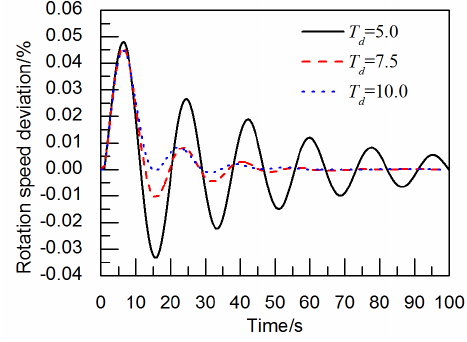
Figure 7. The influence of T d (s) on the unit rotation